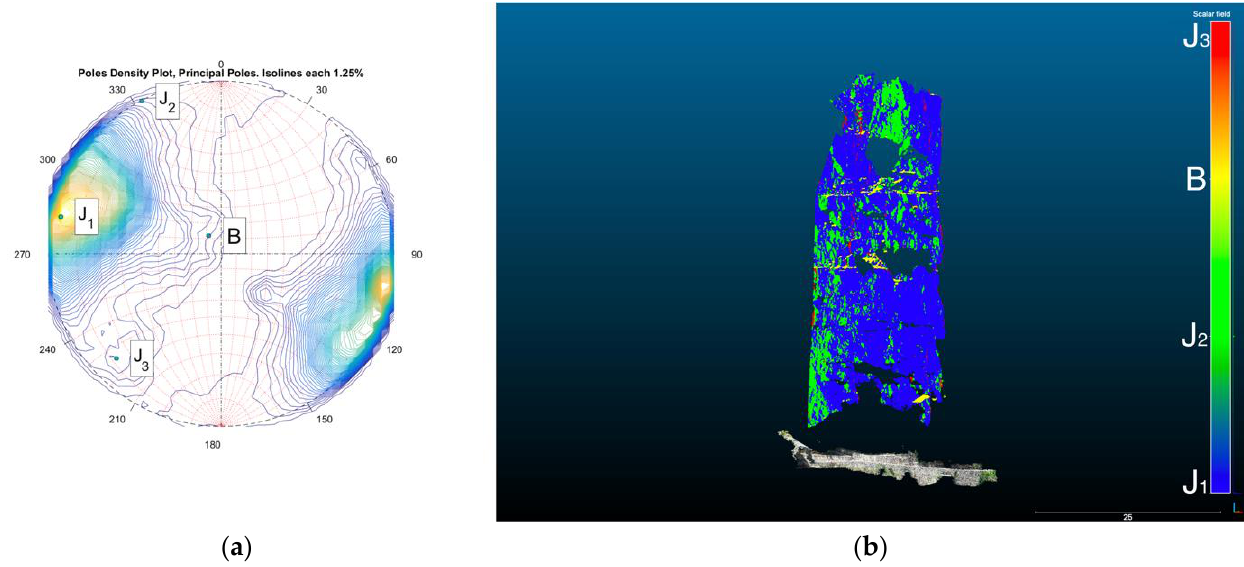
Figure 9. ( a ) Stereographic projections of the DSE-derived discontinuity sets for U4 and ( b ) the visual interpretation of the four (4) main sets in the 3D point cloud.